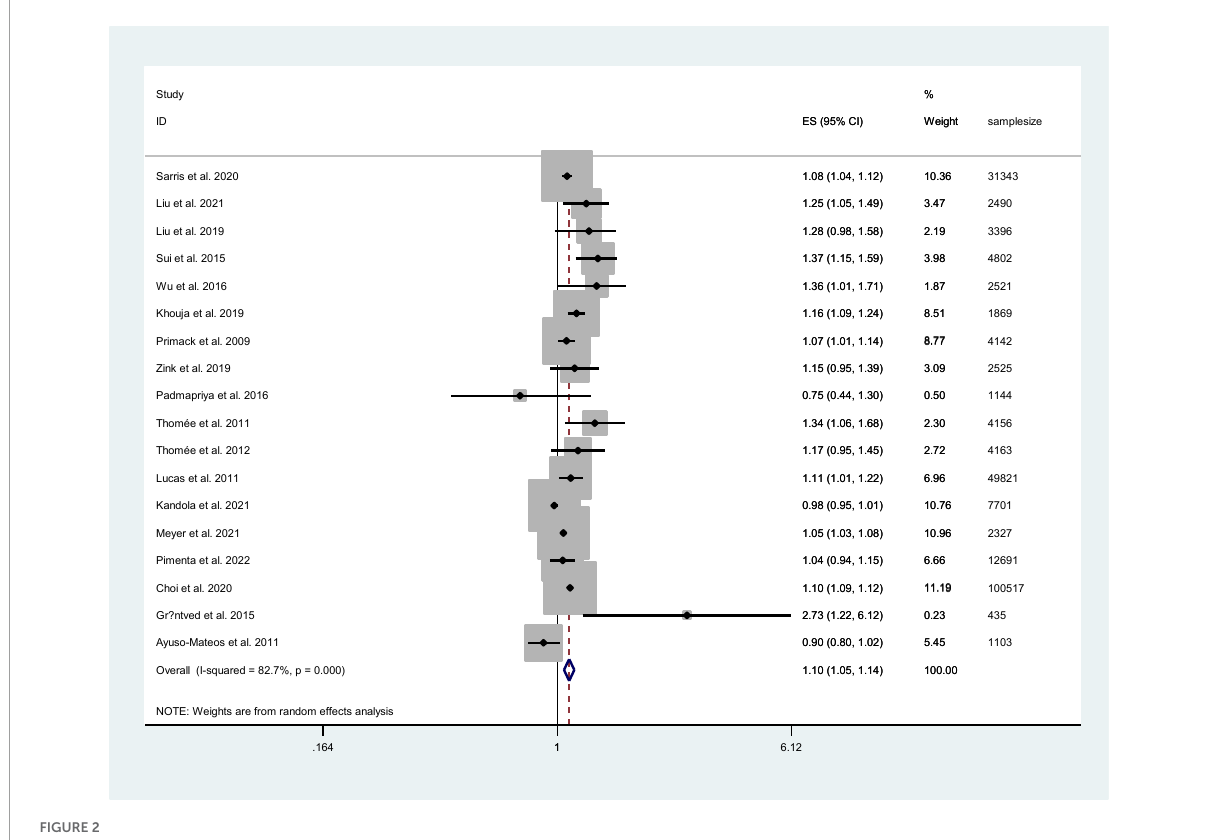
FIGURE2 Forest plot of the association between screen time and the risk of depression.